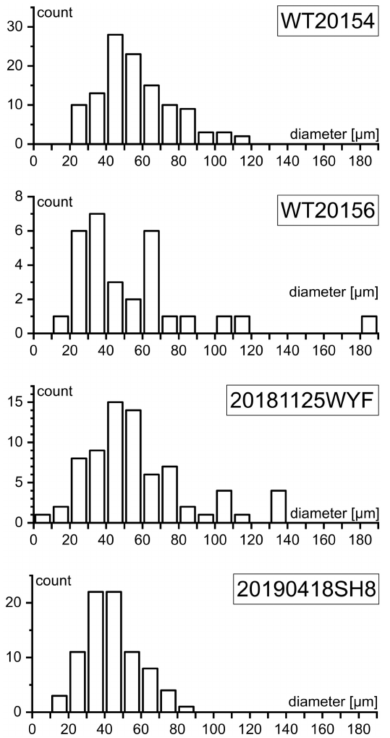
Figure 3. Crystal size distribution measured in 2D of garnet in 4 thin sections. Diameter was measured using backscattered electron images. Some of the largest grains seem exceptionally large.